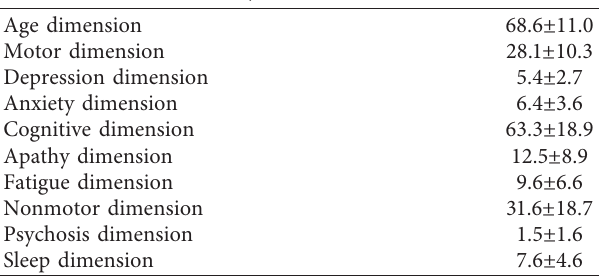
Table 4: Mean ± sd scores of the variables that make up the Parkinson’s Disease Severity